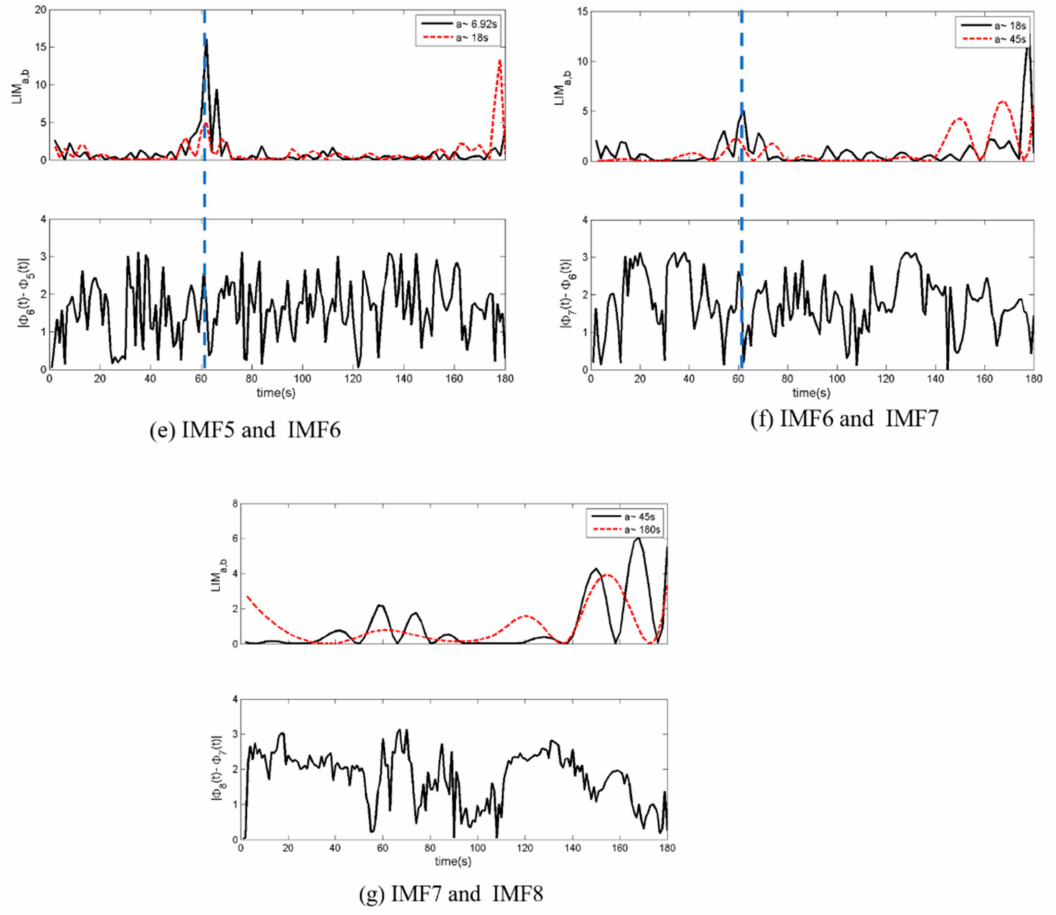
Figure 6. Phase correlations between IMF1 and IMF8 for profile1. ( a – g ) Top panels represent the local energy peaks at two neighboring scales; bottom panels represent the phase difference at two neighboring IMFs. The black line and red line respectively represent the LIM energy peaks of IMFi and IMF i + 1, where i = 1, 2, 3 . . . ., K, K is the number of modal components in VMD decomposition. The blue dotted lines denote that the phase difference is zero when LIM peaks are overlapping.